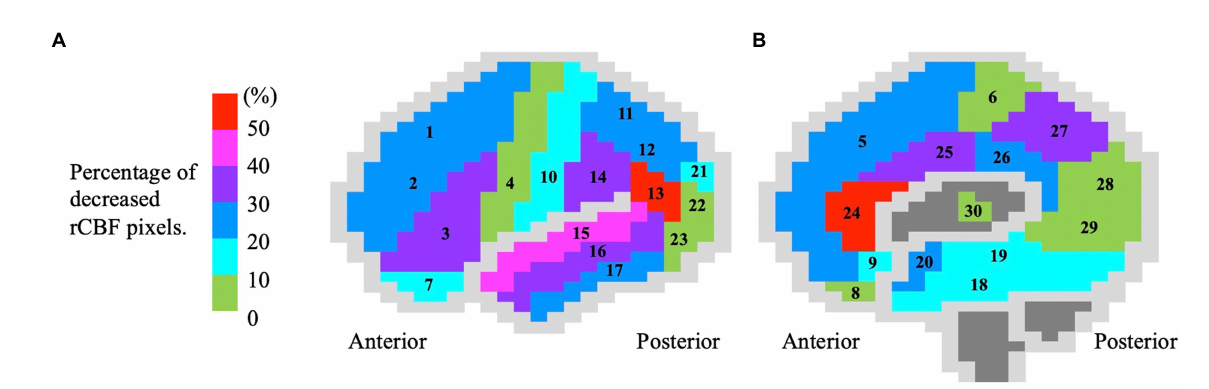
FIGURE 2 Color brain mapping showing the distribution of decreased regional cerebral blood flow in 83 early-stage cognitive impairment patients. The figure shows the (A) lateral and (B) medial sides of the brain. The brain gyrus is colored according to the mean percentage (%) of rCBF reduction ( Z -score > 2), corresponding to the colored bar. The numbers in the figure correspond to the following brain gyrus, (1) anterior frontal gyrus; (2) middle frontal gyrus; (3) inferior frontal gyrus; (4) precentral gyrus; (5) medial frontal gyrus; (6) paracentral lobule; (7) orbital gyrus; (8) straight gyrus; (9) area subcallosal; (10) postcentral gyrus; (11) superior parietal lobule; (12) inferior parietal lobule; (13) angular gyrus; (14) supramarginal gyrus; (15) superior temporal gyrus; (16) middle temporal gyrus; (17) inferior temporal gyrus; (18) fusiform gyrus; (19) parahippocampal gyrus; (20) uncinate gyrus; (21) superior occipital gyrus; (22) middle occipital gyrus; (23) inferior occipital gyrus; (24) anterior cingulate gyrus; (25) cingulate gyrus; (26) posterior cingulate gyrus; (27) precuneus; (28) cuneus; (29) lingual gyrus; and (30) thalamus. rCBF, regional cerebral blood